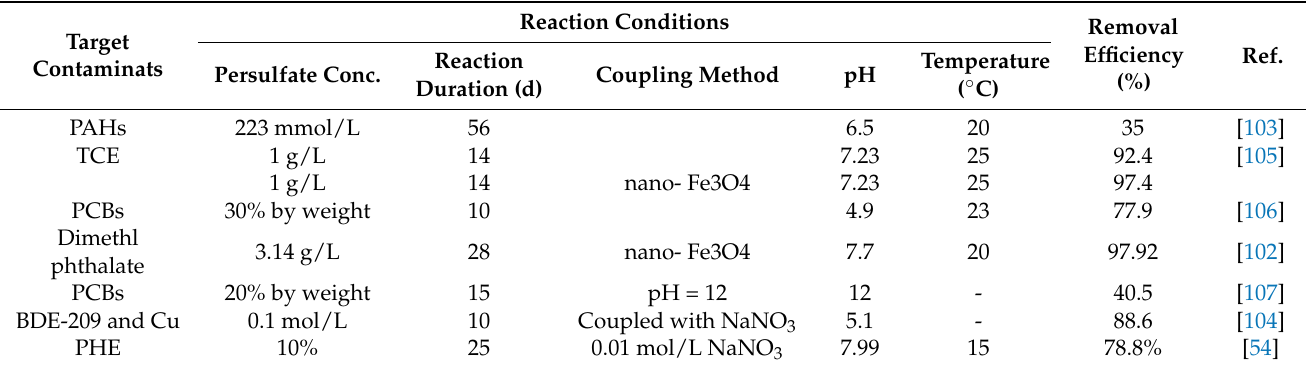
Table 4. Bench-scale and laboratory studies with electrically activated persulfate.